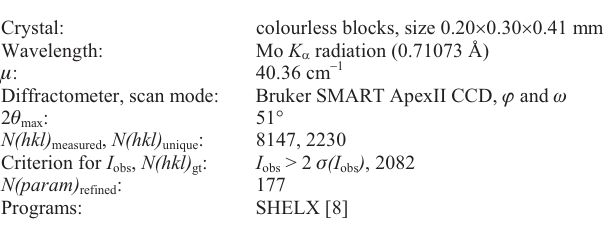
Table 1. Data collection and